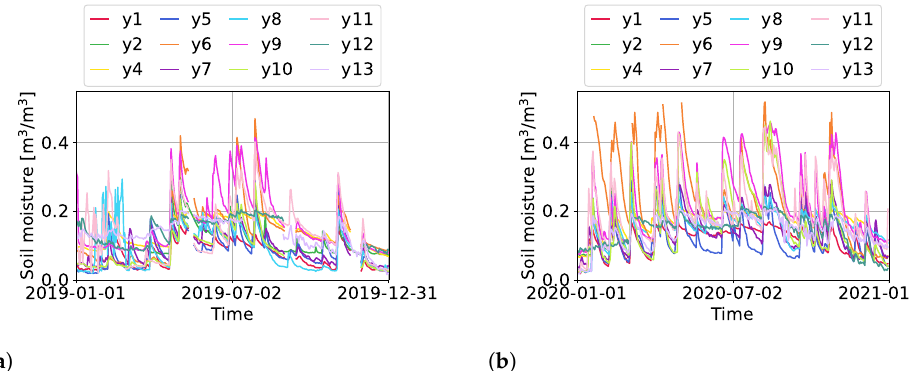
Figure 6. Daily average of in situ soil moisture measurements of SMAP Yanco validation site at 5cm depth. ( a ) Year 2019. ( b ) Year